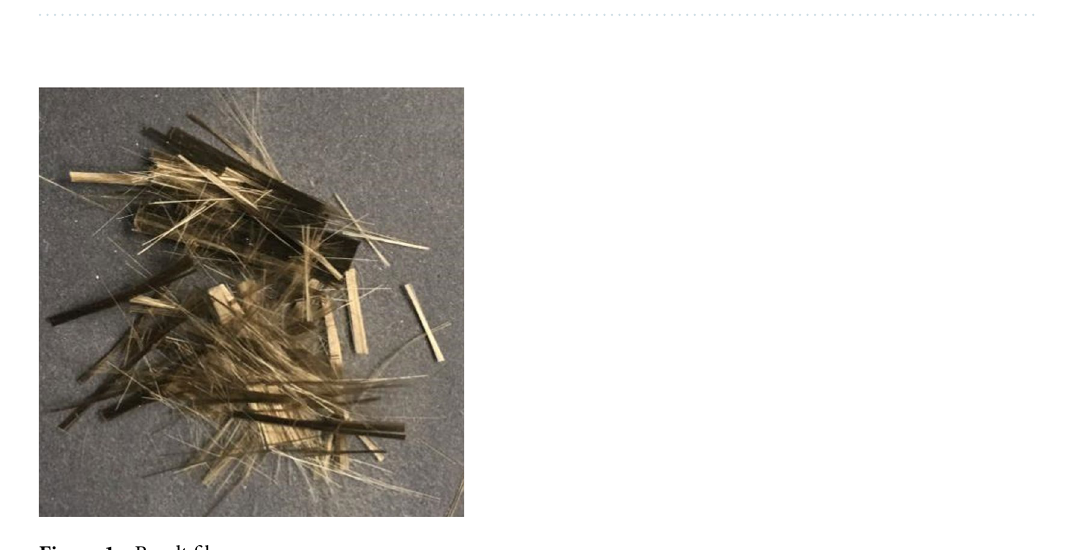
Table 1. Physical properties of the BF.